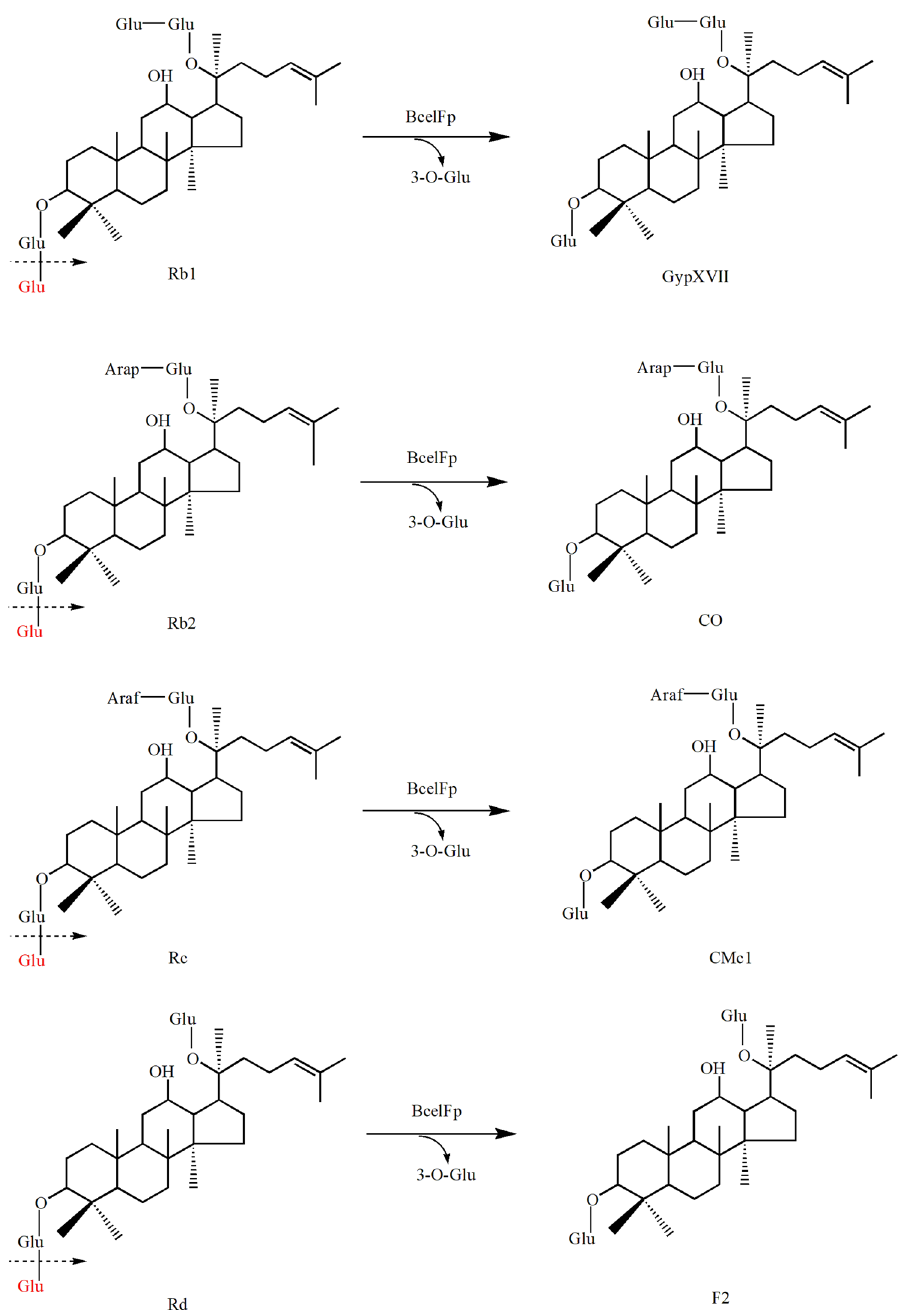
Fig. 6 Biotransformation pathways of ginsenoside Rb1, Rb2, Rc and Rd by using